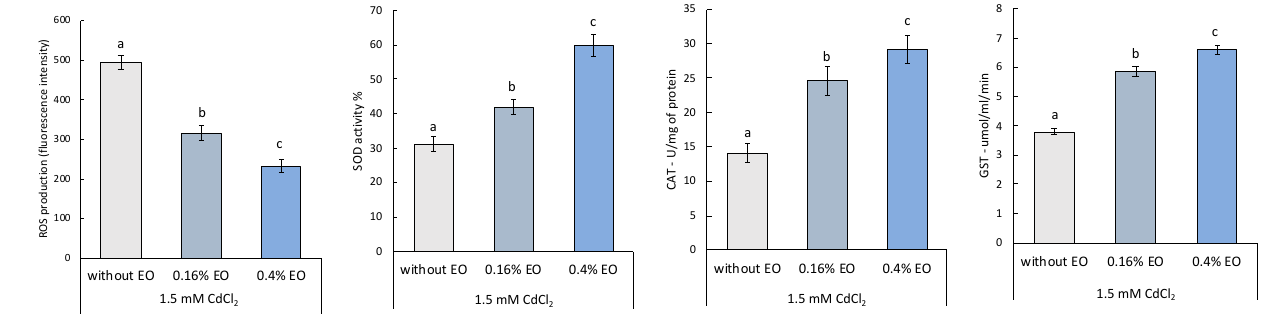
Figure 1. ROS amount and antioxidant/detoxifying enzyme activities (SOD, CAT and GST) in L. riparium gametophytes treated without EOs, with 0.16% and 0.4% of Eos, and after with CdCl 2 . Bars not accompanied by the same letter were significantly different at p < 0.05. Data are mean of three independent experiments ± SE (n = 5).